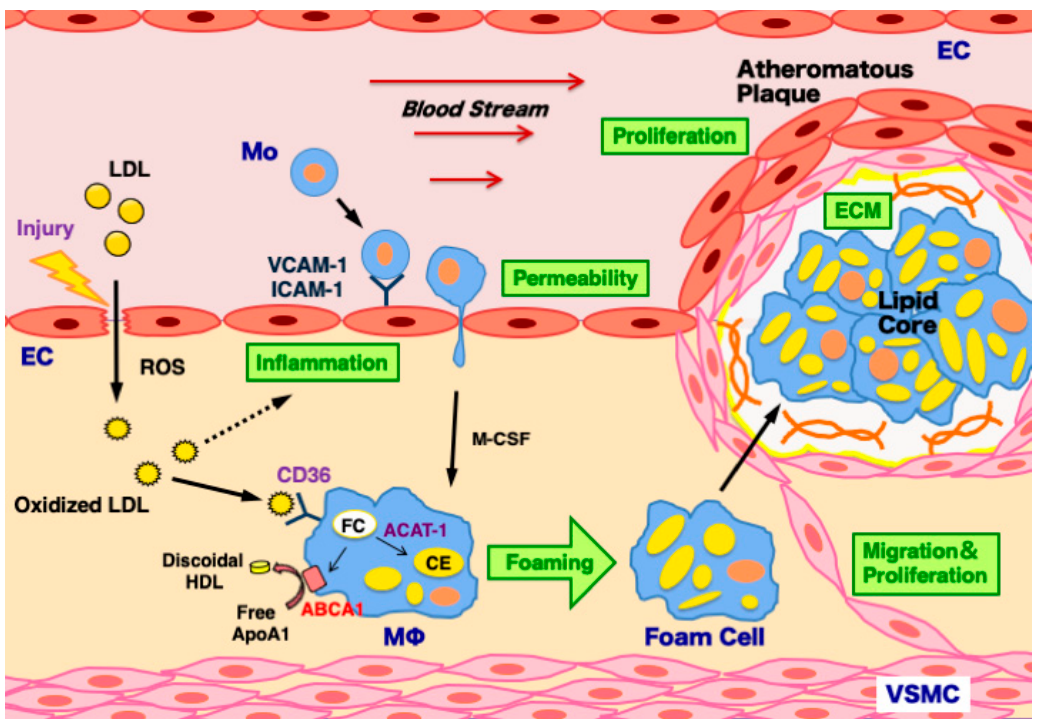
Figure 2. Mechanisms of atherosclerosis development in the arterial wall. Atherosclerosis is triggered by arterial injury-induced inflammation and hyperpermeability in endothelial cells (ECs). This process induces the infiltration of low-density lipoprotein (LDL) particles into the subendothelial space, and LDL is modified to oxidized LDL by reactive oxygen species (ROS), which further accelerates vascular inflammation. It stimulates monocyte adhesion to ECs via vascular cell adhesion molecule-1 (VCAM-1) and intercellular adhesion molecule-1 (ICAM-1) upregulation. Monocytes (Mo) infiltrate into the subendothelial space and then differentiate to macrophages (M ϕ ) by macrophage colony stimulating factor (M-CSF). Macrophages uptake oxidized LDL via its receptor CD36 upregulation, and transform to foam cells via the decreased efflux of free cholesterol (FC) by the ATP-binding cassette transporter A1 (ABCA1) downregulation and increased cholesterol ester (CE) biosynthesis by acyl coenzyme A: cholesterol acyltransferase-1 (ACAT-1) upregulation. The massive accumulation of foam cells results in the formation of lipid core. To surround it, vascular smooth muscle cells (VSMCs) migrate, proliferate, and produce extracellular matrix (ECM), leading to the development of atheromatous plaques.